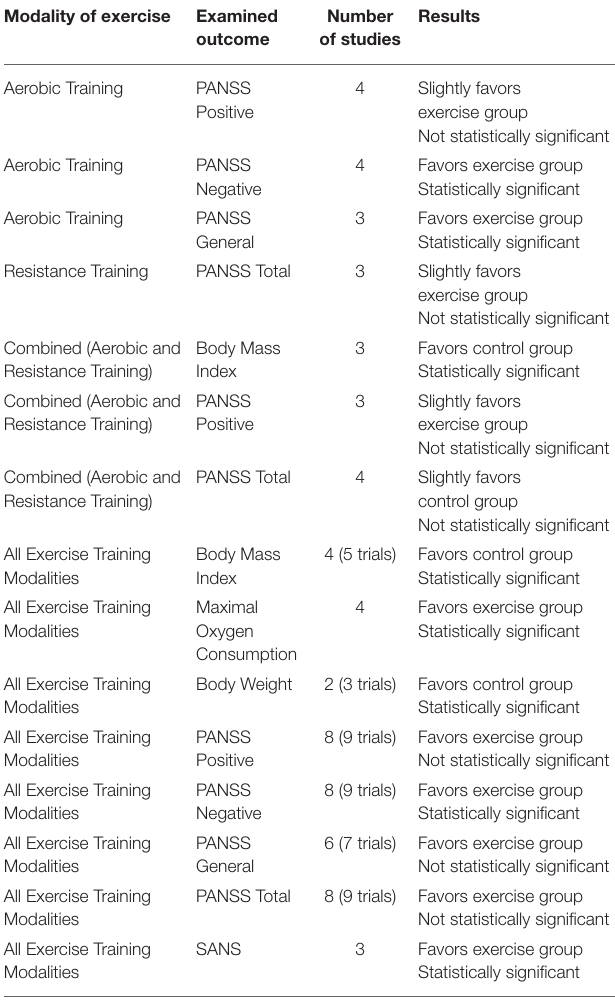
TABLE 3 | Summary of quantitative results by modality of exercise and